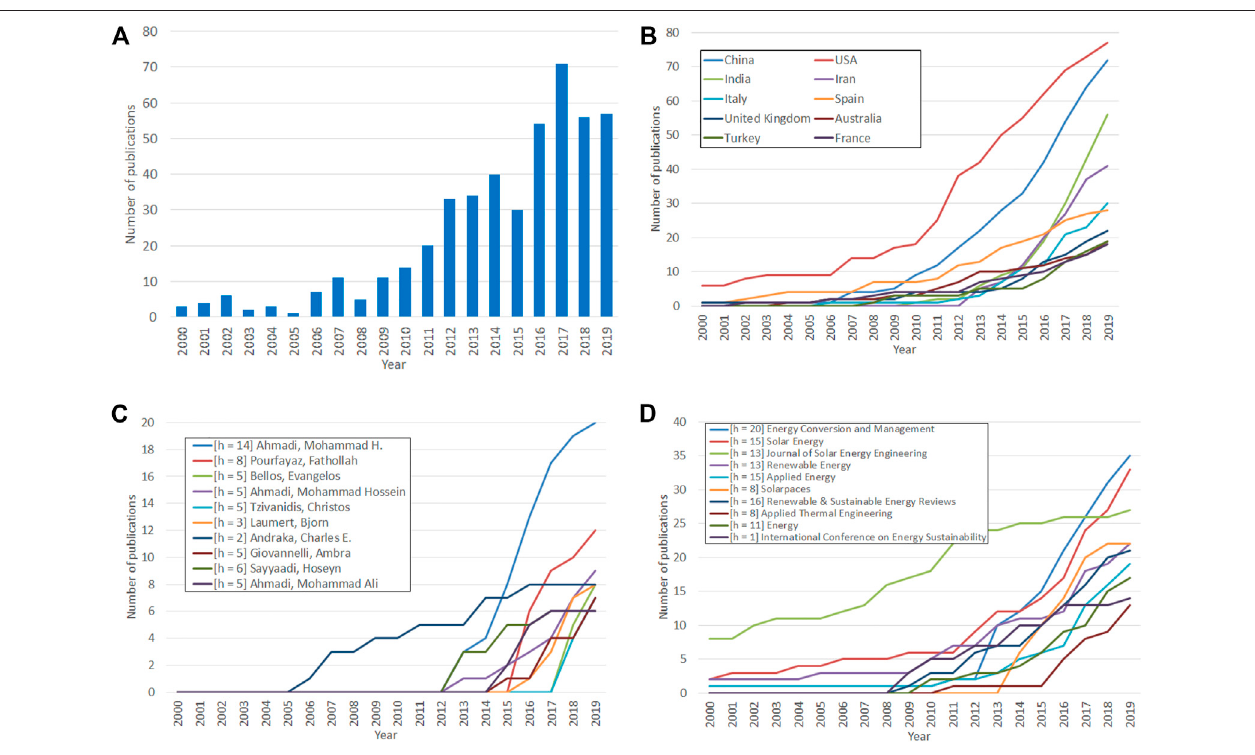
FIGURE 14 | (A) Total publication evolution in the Stirling dish fi eld per year; (B) Total publications in Stirling dish per country; (C) Cumulative publication evolution per year of the top ten authors in the Stirling dish fi eld; (D) Publication evolution per journal/source in the Stirling dish fi eld by number of publications.